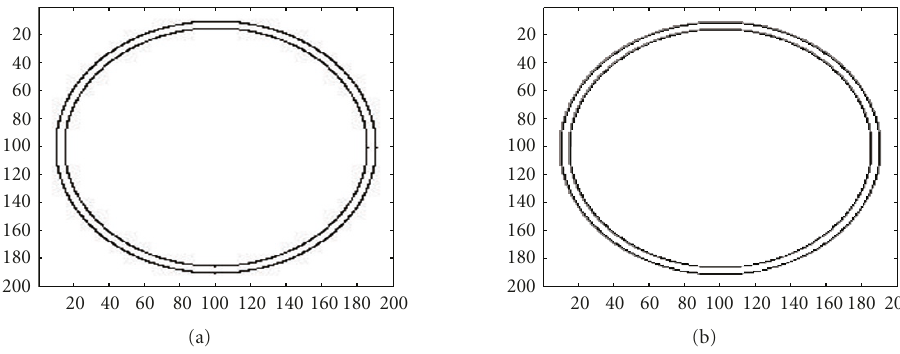
Figure 3: Center and radius estimation, two circles: (a) processed, (b) result (superimposed), with the proposed method for radius estima- tion or equivalently with GHT: ME ρ = 0 . 1 (resp., 0.3 for GHT).